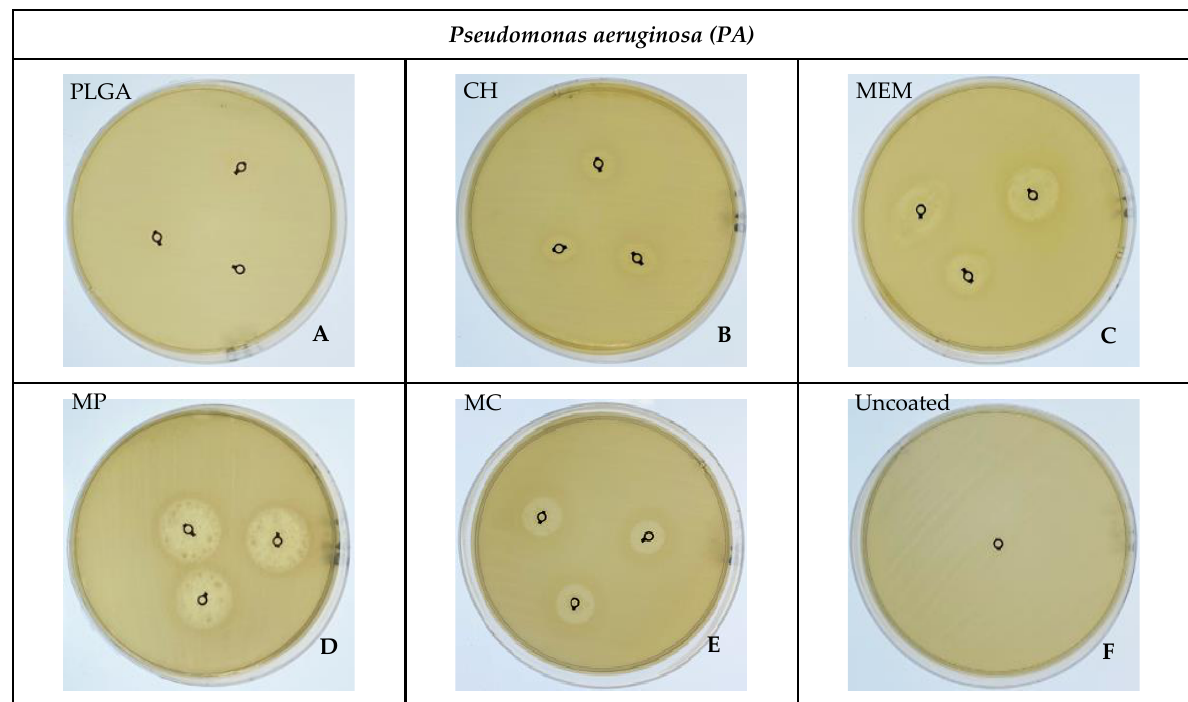
Figure 4. Showing the inhibition zones among the different materials against PA . Table 1. Zone of inhibition among the different materials for SA and PA .